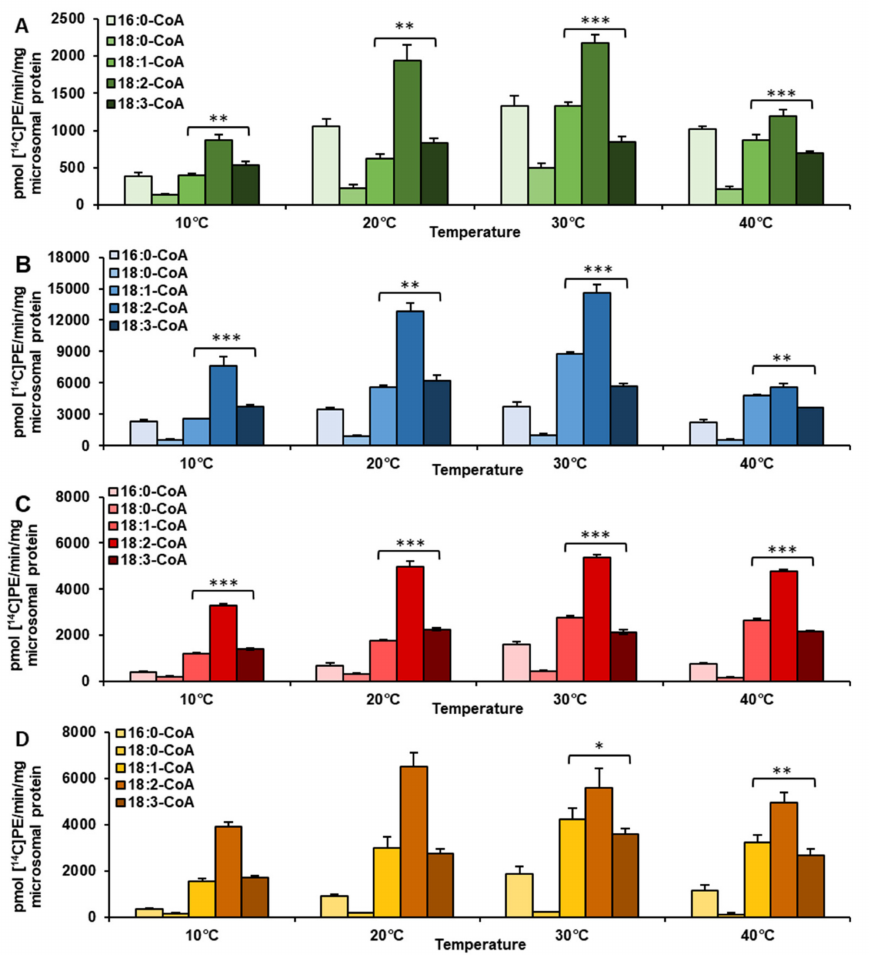
Figure 1. Activity of acyl-CoA:lysophospatidylethanolamine acyltransferases (LPEATs) present in microsomal fractions of Camelina sativa tissues towards five acyl-CoAs at different temperatures. (( A )—in vivo leaves; ( B )—in vitro leaves; ( C )—n vitro roots; ( D )—seeds). Mean values and SD are presented (data from at least three independent assays). Asterisks denote significant differences between activity towards 18:1-CoA and 18:3-CoA at different temperatures in a mean difference two-sided Student’s t test: * p ≤ 0.05; ** p ≤ 0.01; *** p ≤